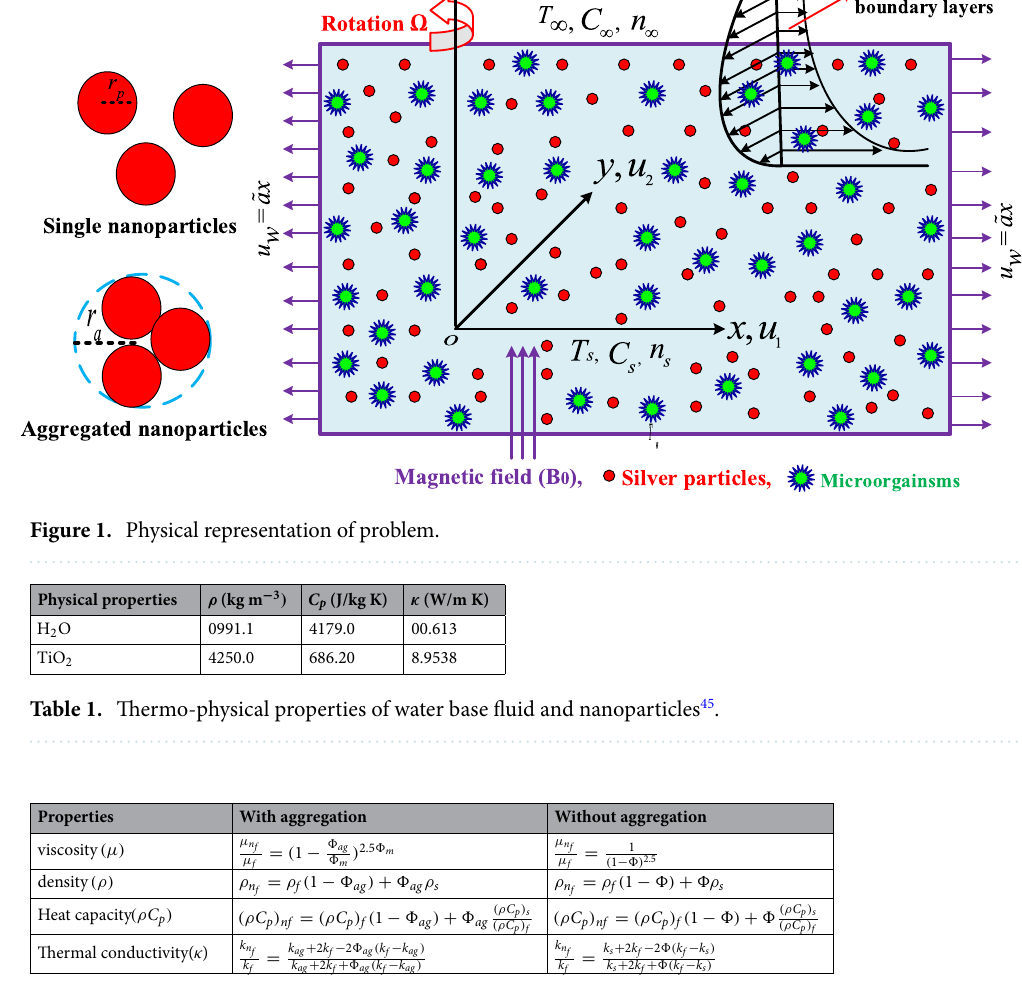
Table 2. Thermo-physical attributes of base fluid and nanoparticles 45,46 .